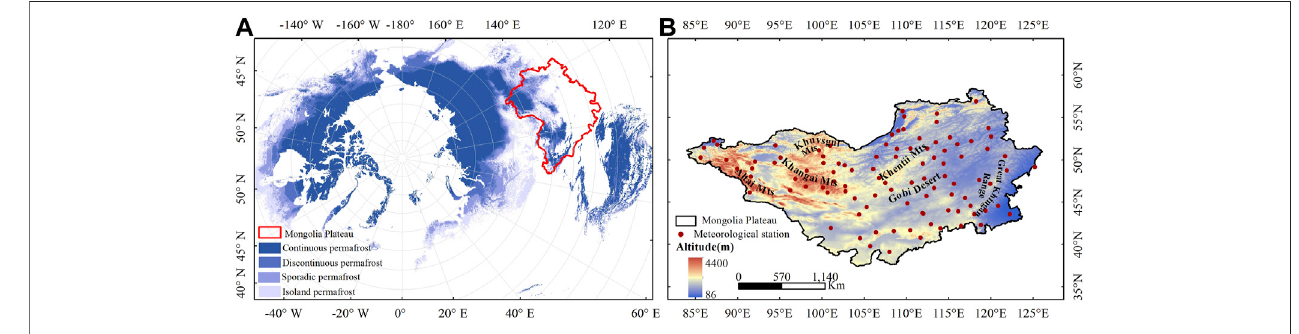
FIGURE 1 | The location of the Mongolian Plateau in the permafrost region of the Northern Hemisphere (A) and the distribution of meteorological stations (B) . The permafrost distribution data in the Northern Hemisphere (A) are derived from Obu et al. (2019) via the data source